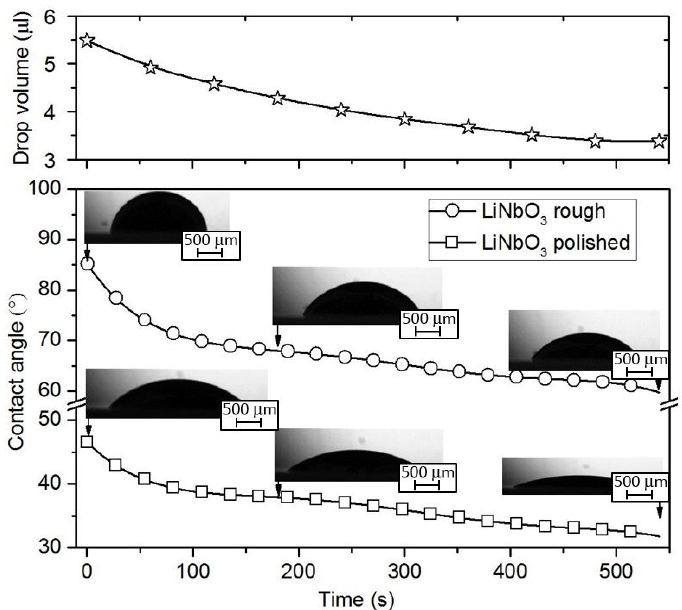
Figure 7. Time dependences of the contact wetting angle of Ag nano-ink deposited on a rough or polished surface of LiNbO 3 sample during drop drying. Time dependence corresponding to the change in the drop volume on dry out is shown above.